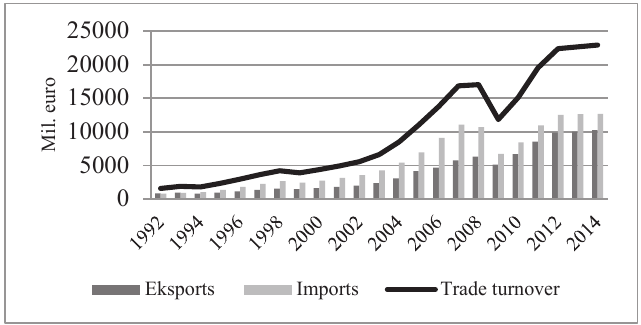
Fig. 1. Foreign trade dynamics of Latvia, million EUR (CSB of Latvia).